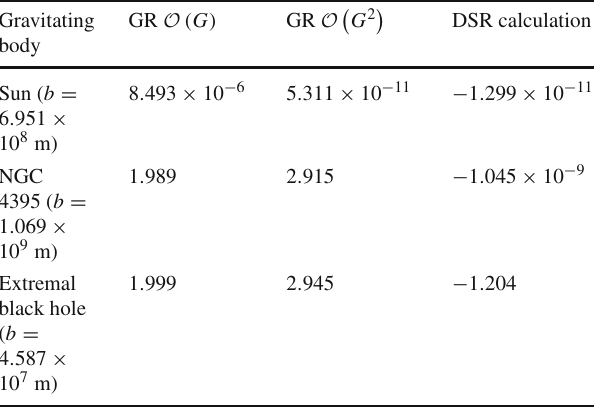
Table 1 The deflection of light across a selection of gravitating bodies. The impact parameter in the case of the Sun is its radius, and for the two Black Holes their respective Schwarzchild radii. All results are stated in radians and the values are computed using equations Eqs. 19, 20